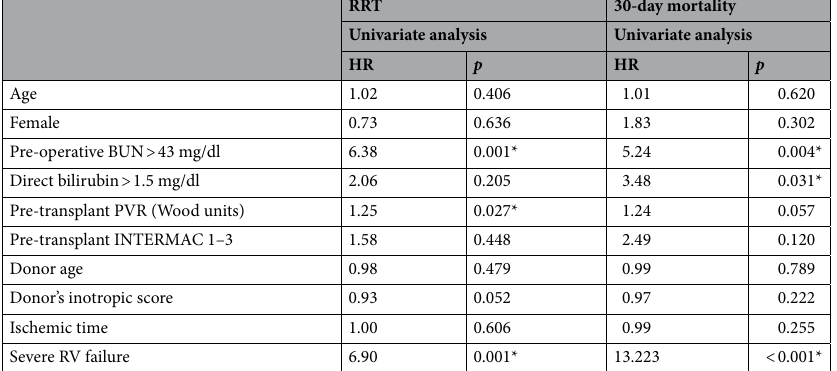
Table 5. Univariate analyses for predictors of 30-day mortality and post-transplant dialysis (RRT) in the absence of sepsis and CNI. BUN blood urea nitrogen, INTERMACS Interagency Registry for Mechanically Assisted Circulatory Support, PVR pulmonary vascular resistance, RRT renal replacement therapy, RV right ventricular. * P value < 0.05 is statistical significance.